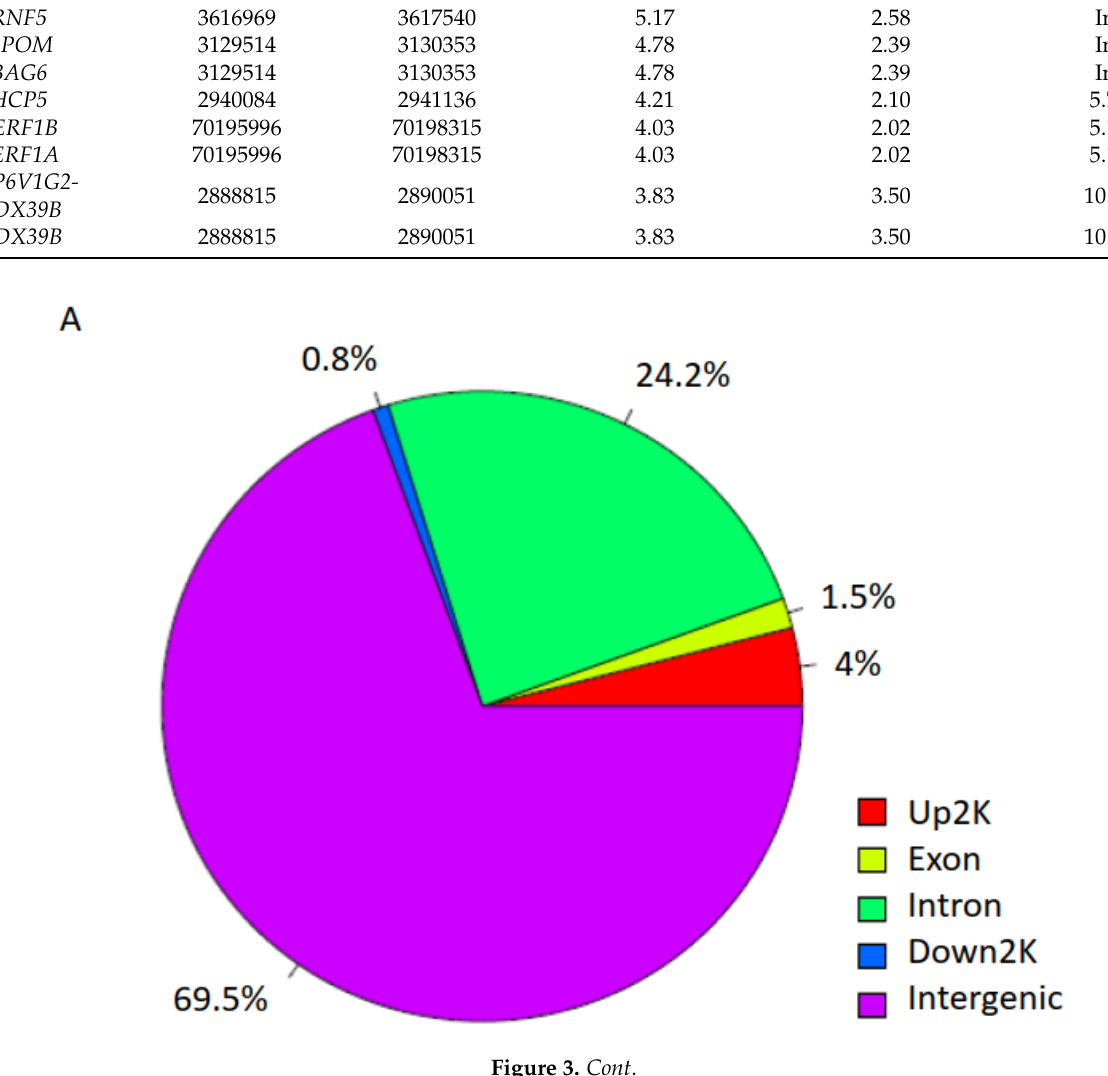
Figure 2. H3K9ac is predominantly lost in T2D. ( A ) Scatter plot of H3K9ac fold-change vs. peak size average (measured as area under the curve or AUC) for ND vs. T2D. ( B ) Histogram of H3K9ac fold-change vs. frequency for peaks with significant ( p < 0.05, Welch’s t test, two-sided) H3K9ac changes (blue dots in ( A )). 3.3. H3K9ac-Enriched Genomic Regions in T2D Coincide with Genetic Loci Associated with T2D and Type 1 Diabetes (T1D) Table 3. Top genetic loci with decreased H3K9ac enrichment in atherosclerosis patients with T2D. We then mapped and profiled T2D H3K9ac enrichment in annotated genomic re- gions. A comparison of ND and T2D H3K9ac enrichment revealed 181 genomic regions unique to T2D (top 10 loci displayed in Tables 2 and 3; full gene list presented in Table S1). About 69.5% of the differentially enriched regions fall into intergenic regions; 24.2% in introns; 4% upstream and 0.8% downstream of the TSS; and 1.5% in exons (Figure 3A). Among these genes, 118 displayed increased (Tables S1 and S2) and 63 showed decreased